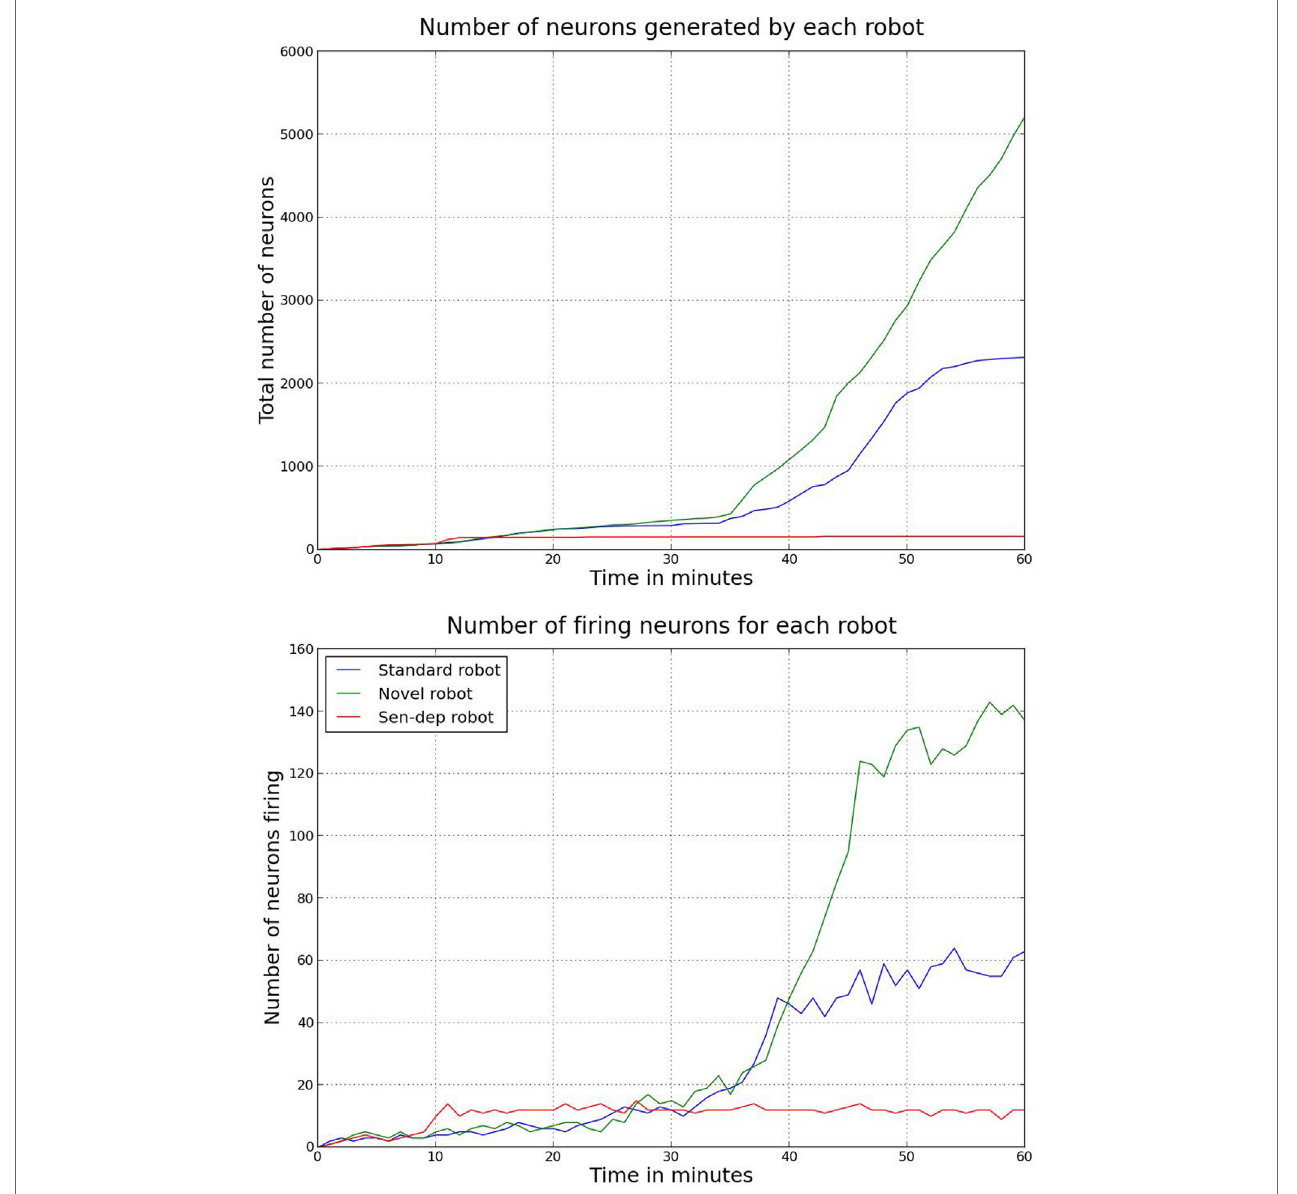
FigUre 10 | The total number of neurons generated by the enn for each of the robots over the course of the experiment (top) as well as the total number of firing nodes (bottom) . The nodes themselves are generated as a function of the robots interaction with its environment. A higher number of nodes would suggest that the robot has learned about a larger number of, or in more detail about, different objects or aspects of its environment. A higher number of nodes firing appear to be related to the robot either noticing more aspects of the environment or having a greater understanding of the affordance of different aspects of the